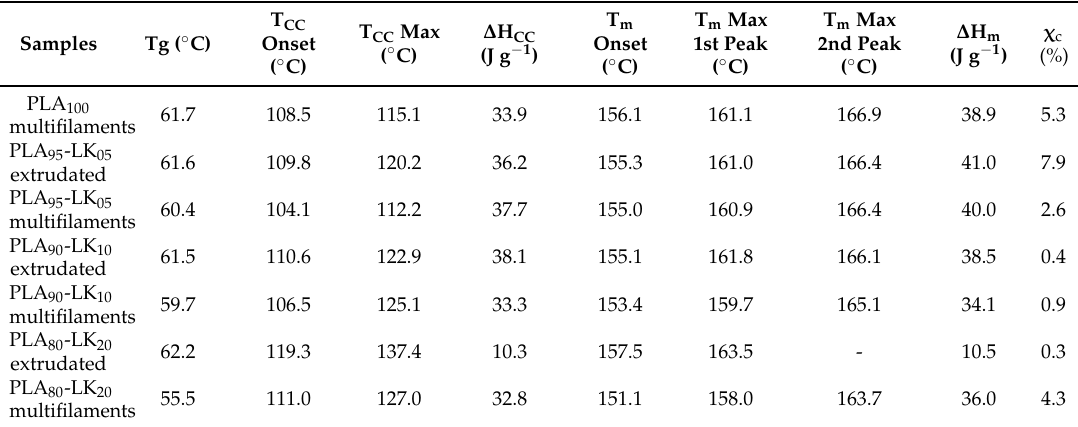
Figure 2. Scanning electron microscopy ( A , B ) and optical microscope ( C , D ) observations of PLA 95 -LK 05 ( A , C ) and PLA 80 -LK 20 ( B , D ) multifilaments. Table 4. Thermal properties of PLA and PLA-LK samples.